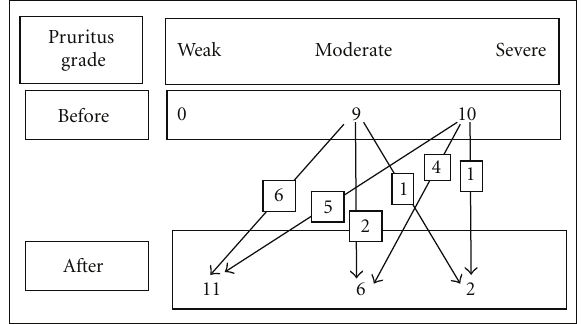
Figure 1: Patients allocation based on the grade of pruritus before and after treatment with sertraline.